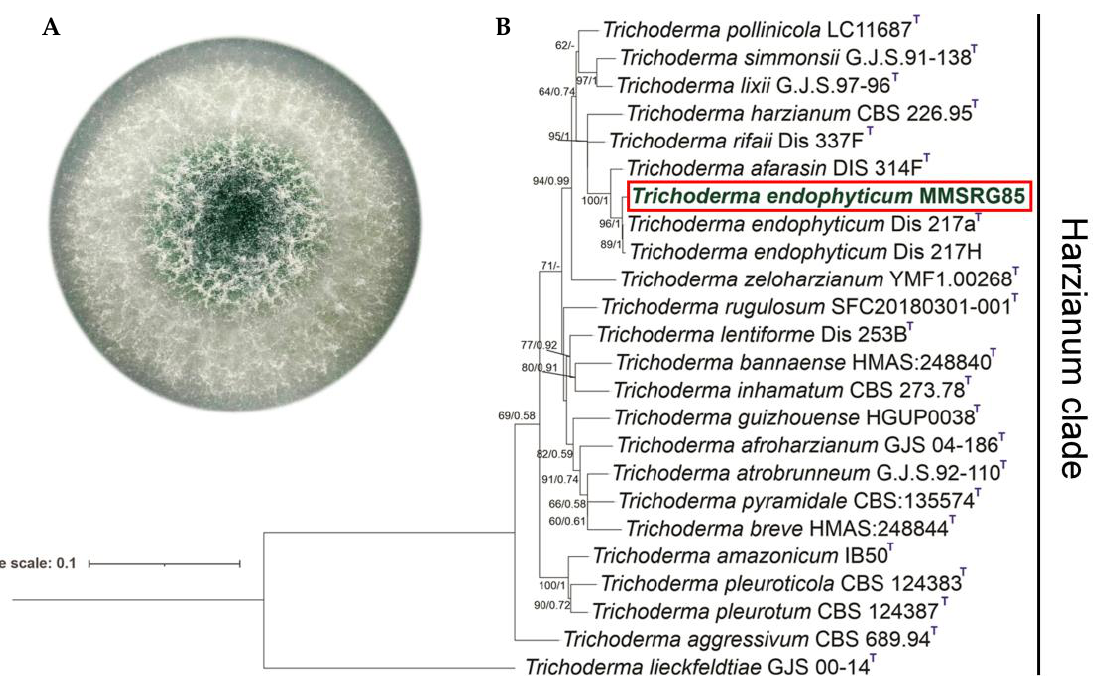
Figure 1. ( A ) Morphology in PDA medium of T. endophyticum MMSRG85 strain isolated from ascidian Botrylloides giganteus . ( B ) Phylogram generated by the concatenation of the sequences tef1- α and rpb2 of Trichoderma species of the clade Harzianum . The numbers indicate the support of the branches (ML/PP). The strain analyzed in this study is marked in green bold text and with a red box.